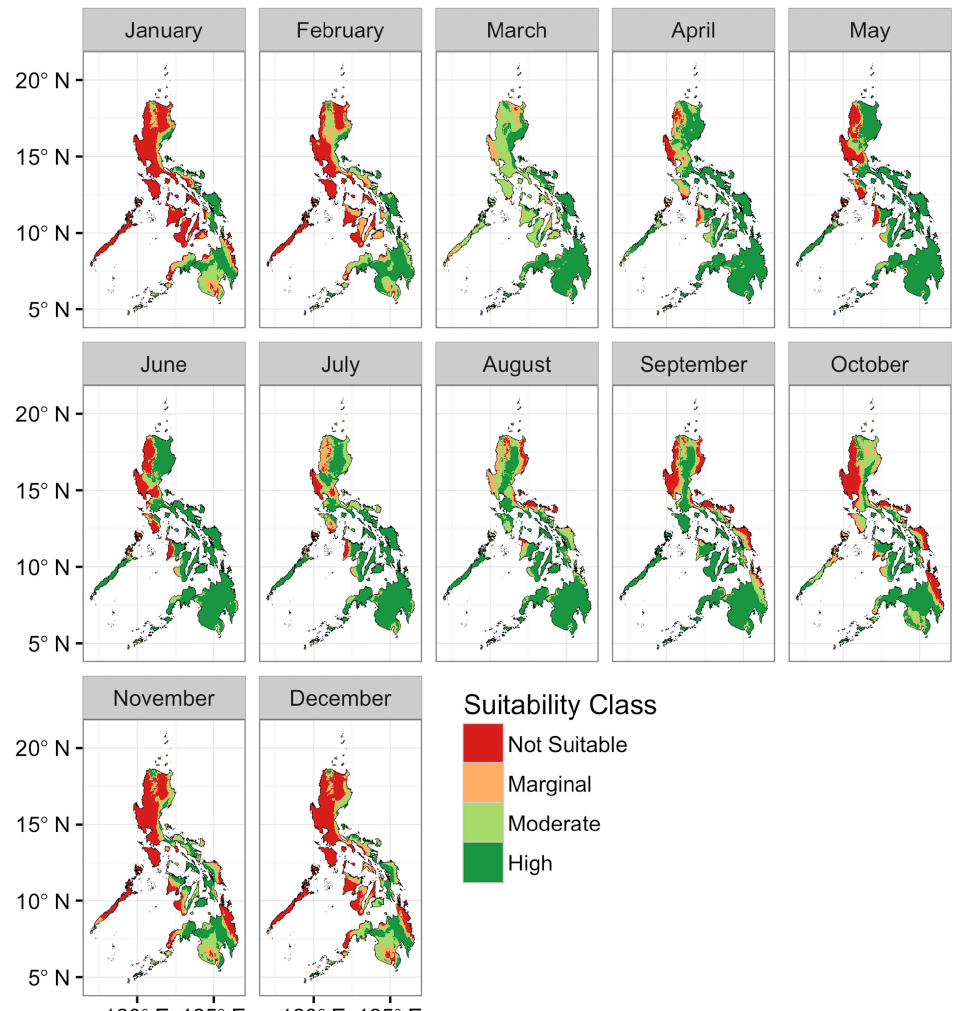
Fig. 8. Monthly spatial distribution of climatic suitability of corn based on rainfall in the Philippines under baseline